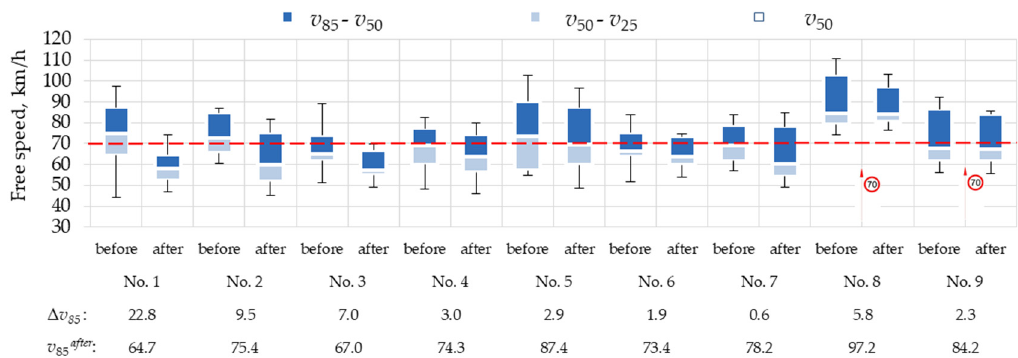
Figure 4. Distribution of free-flow speed ranges on the test section according to the speed reduction value ∆ v 85 .